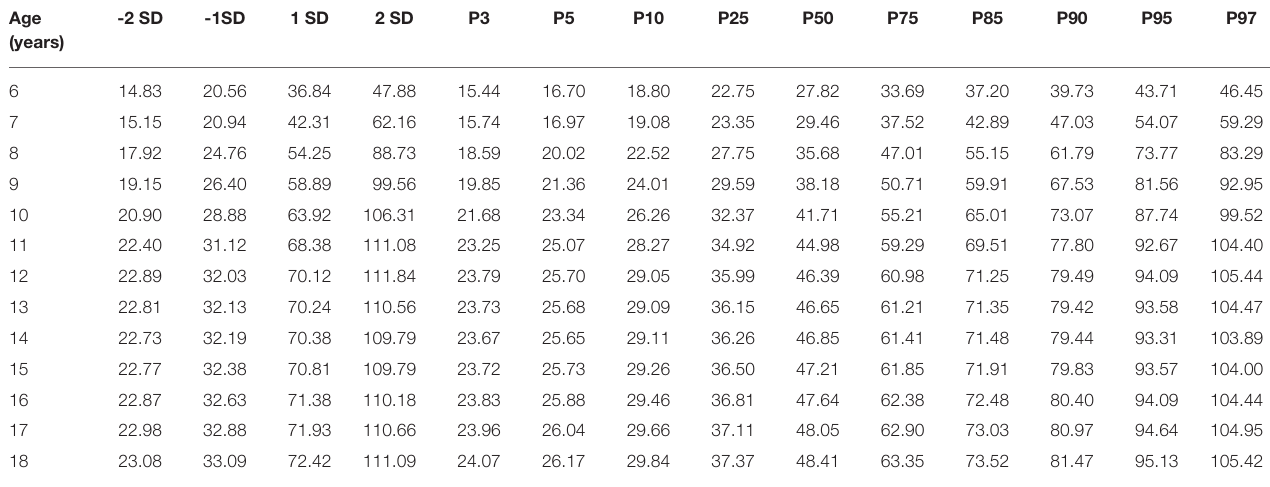
TABLE 4 | VAT-for-age (cm 2 ) references for